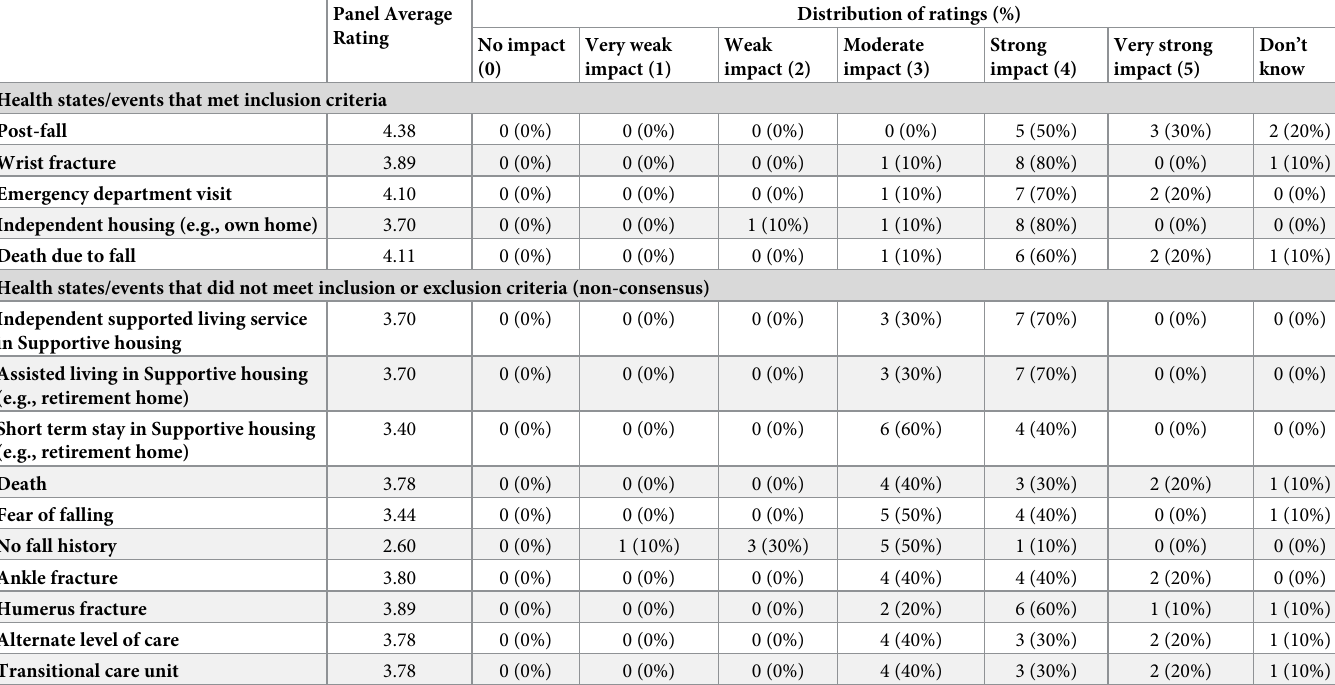
Table 4. Summary of health states/events ratings from the second Delphi